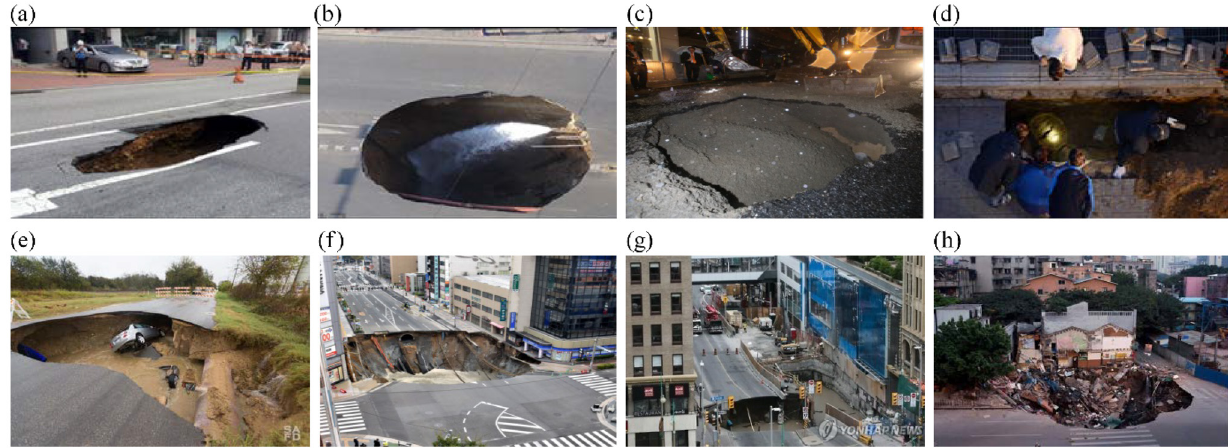
Figure 1. Ground subsidence near subways: (a) Seokchon subway station, (b) Bakchon subway station, (c) Samseongjungang subway station, (d) Janghanpyeong subway station in South Korea, (e) Texas in the US, (f) Fukuoka in Japan, (g) Ottawa in Canada and (h) Guangzhou in China.